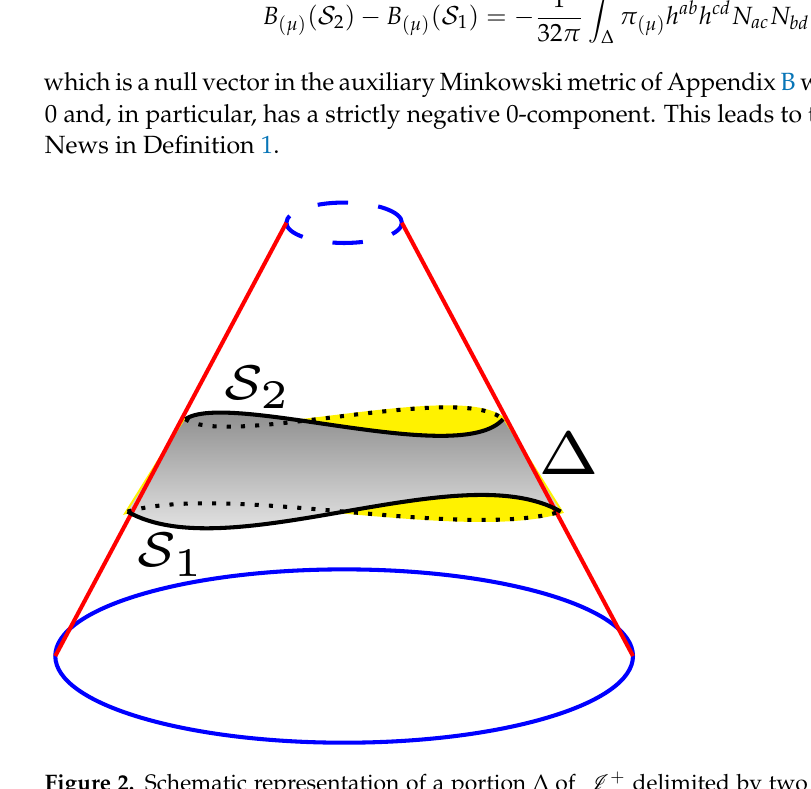
∆ has the same S 2 is in the future of 1 . The portion